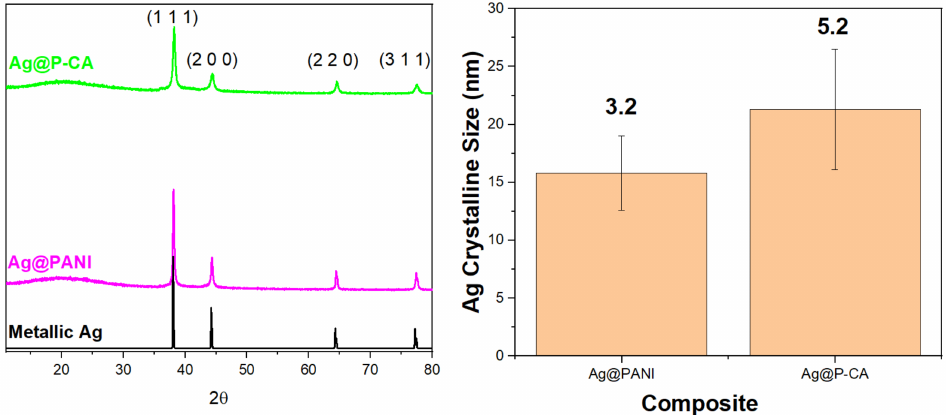
Figure 5. Left panel : XRD patterns of Ag@PANI-based composites and their characteristic diffraction profiles. Metallic Ag represents the calculated pattern of fcc Ag (RRUFF ID: R070463.9). Right panel: Comparison of the size and the homogeneity of the particle size of the Ag clusters in different composites based on the XRD results. The numbers above the columns indicate the standard deviation (nm). Four diffraction peaks were analyzed for each composite to obtain the Ag crystalline sizes and standard deviations. The microstrain effect and instrumental broadening were considered in the size